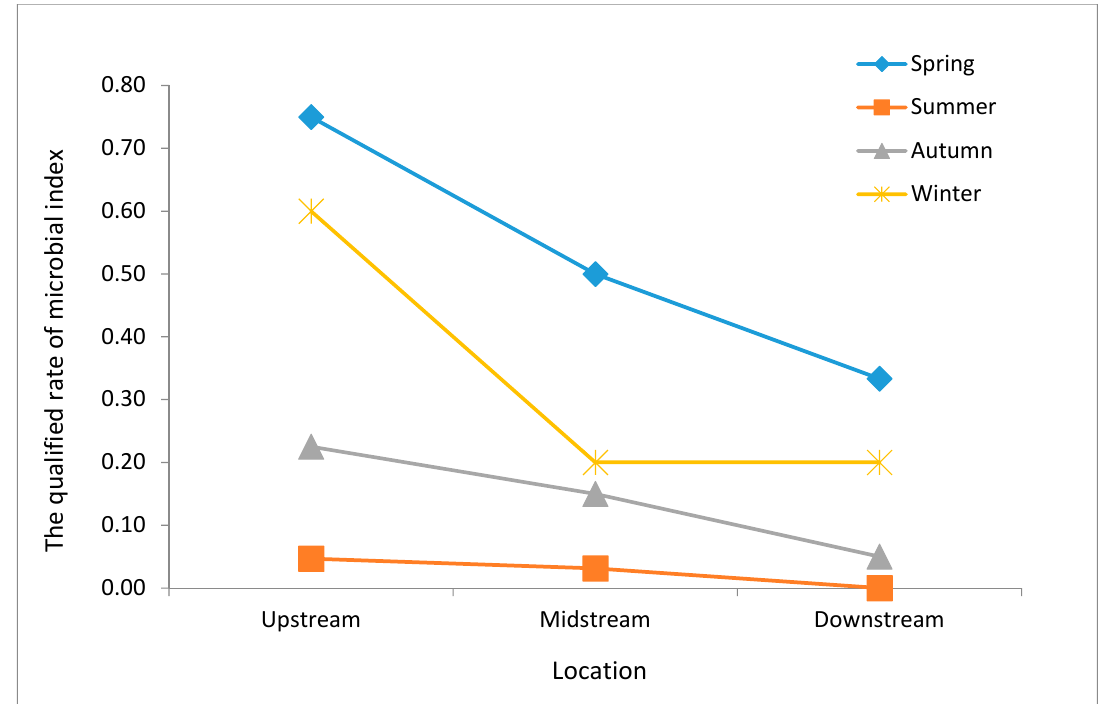
Figure 5. Water qualified rate values for different river sections.